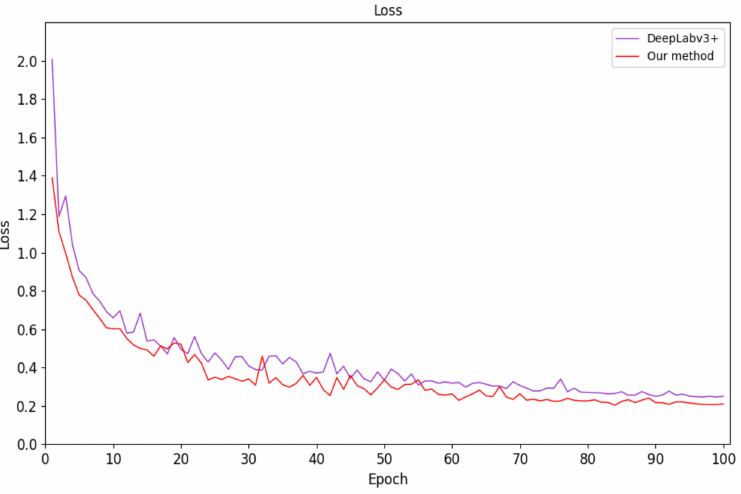
Figure 8. Network-model-validation loss